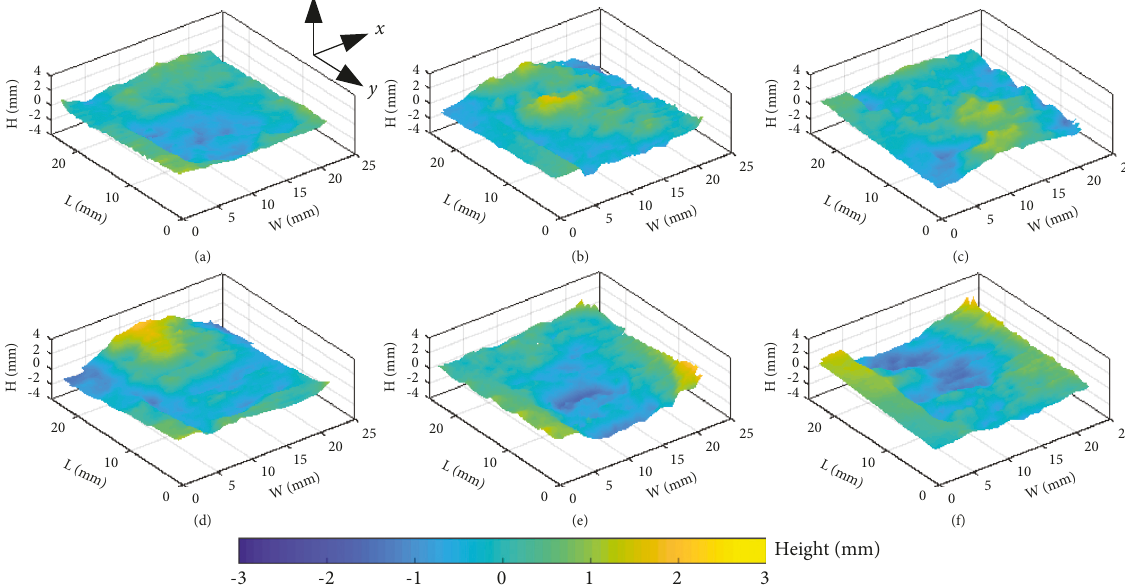
Figure 10: The digitalized fracture surfaces of damaged specimens: (a)–(f) corresponding to D